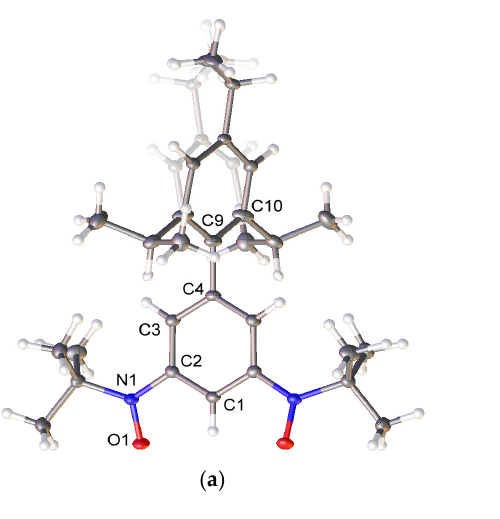
Figure 2. ( a ) X-ray crystal structure of iPr 3 BPBN with thermal ellipsoids at the 50% probability level for non-hydrogen atoms. A disordered position is shown with shaded atoms. A Selective atomic numbering is also shown. ( b ) Temperature dependence of χ m T and χ m − 1 for iPr 3 BPBN measured at 0.5 T. A solid line stands for the Curie–Weiss analysis. Inset: the M-H curve of iPr 3 BPBN measured at 1.8 K.